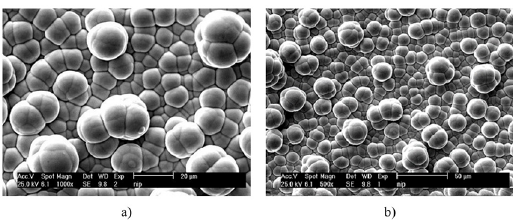
Figure 6. SEM micrographs of Ni-P electroless coating morphology applied on a low carbon steel, a) 1000 mag, b) 500 mag.